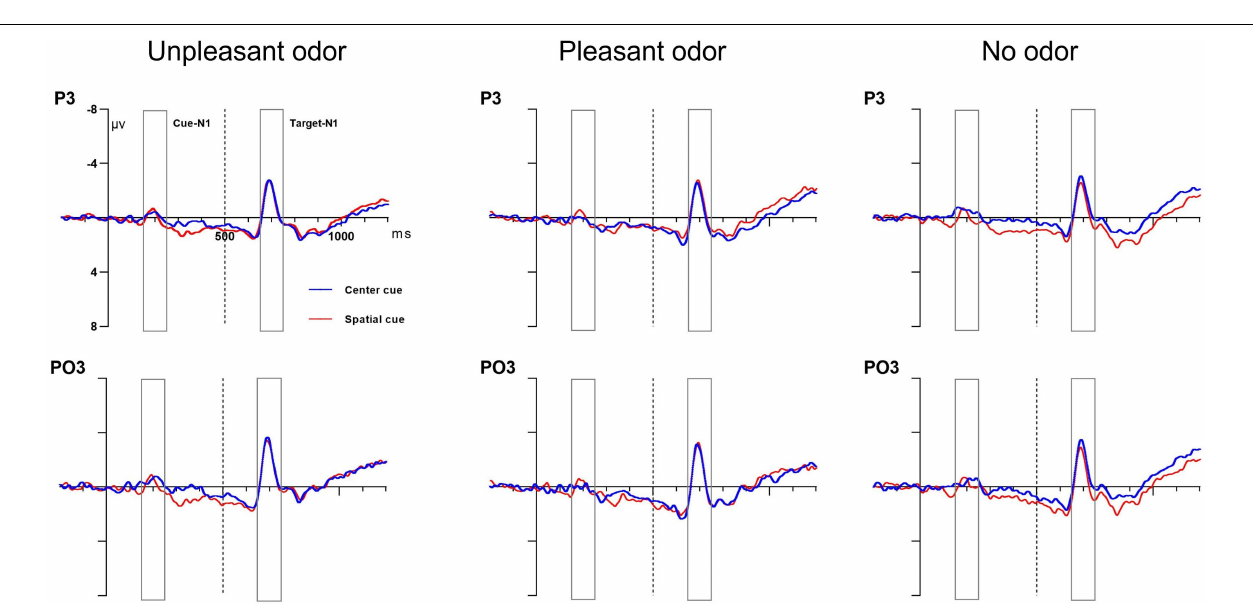
FIGURE 6 | Grand average ERP cue amplitude data for the orienting network. Center cue (blue lines) and spatial cue (red lines) conditions at electrodes P3 and PO3. Cue onset at 0 ms (solid line) and target onset at 500 ms (dashed line).